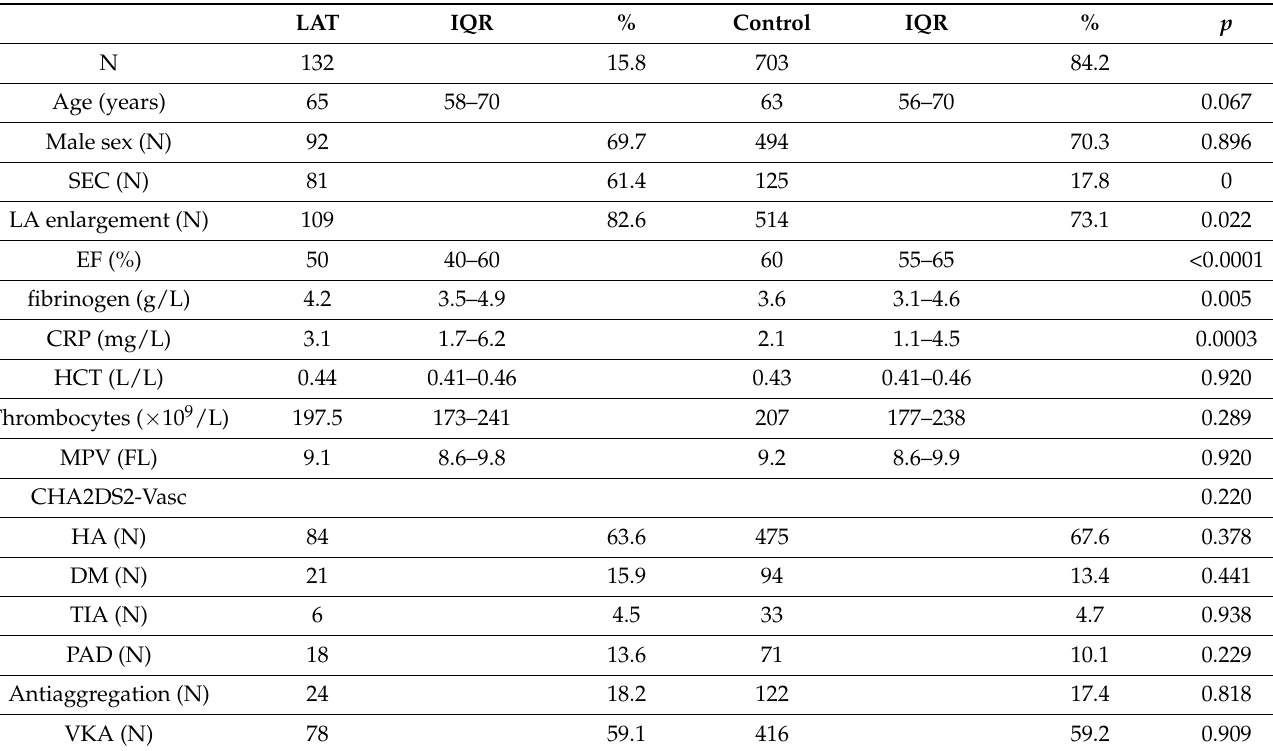
Table 1. The difference between the LAT group and the control group regarding clinical, laboratory and echocardiographic variables